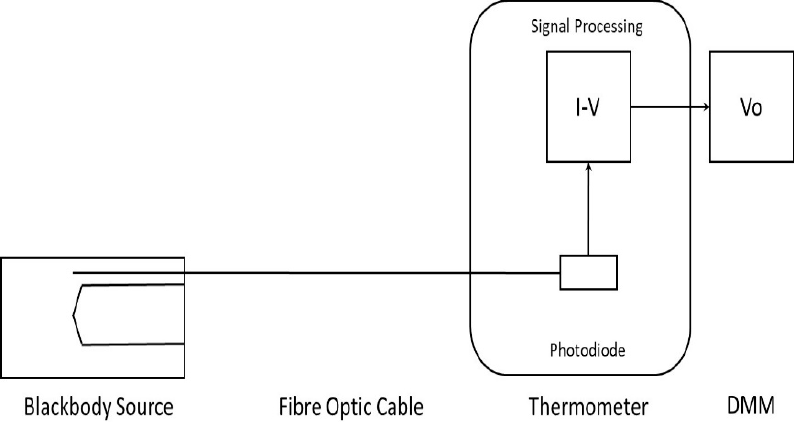
Figure 4. Configuration of laboratory testing of fiber optic thermometer.